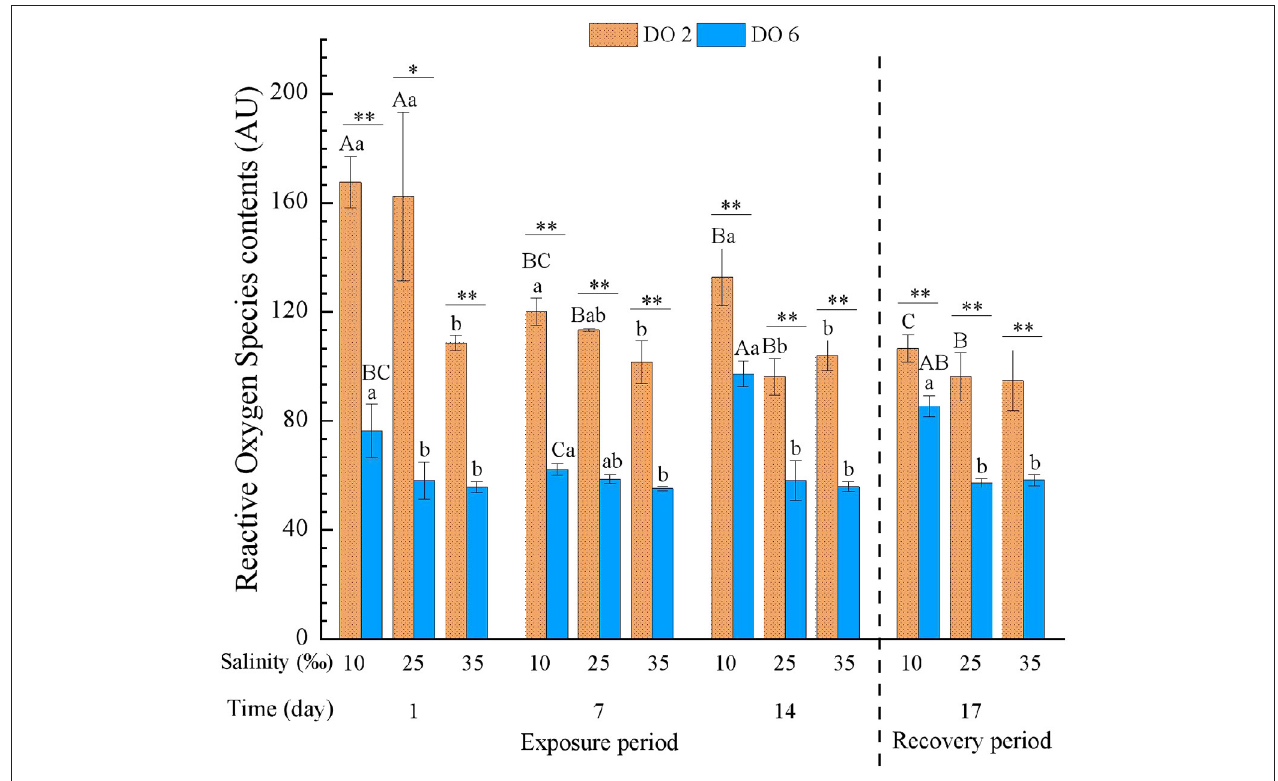
FIGURE 2 | Reactive oxygen species (ROS) of C. hongkongensis exposed to six combinations of salinity (10, 25, and 35 ‰ ) and DO (2 and 6 mg/L) at 1, 7, and 14 days during the exposure period and 3 days for the recovery period. Different capital letters indicate significant differences among time points within each salinity level in hypoxia level (2 mg/L) or control group (6 mg/L) ( p < 0.05). Different small letters indicate significant differences between salinity within each time point in salinity level in hypoxia level (2 mg/L) or control group (6 mg/L) ( p < 0.05). Asterisk indicates significant differences between DO within each time point and fixed salinity treatment, in which * represents significant difference ( p < 0.05) and ** represents highly significant difference ( p < 0.01).